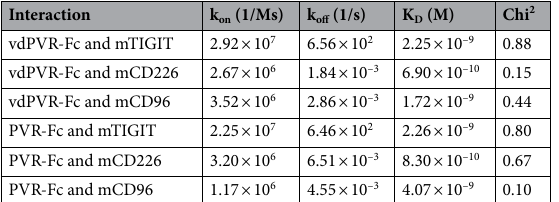
Table 1. Summary of vdPVR-Fc and PVR Fc binding kinetic parameters calculated from SPR sensorgrams.